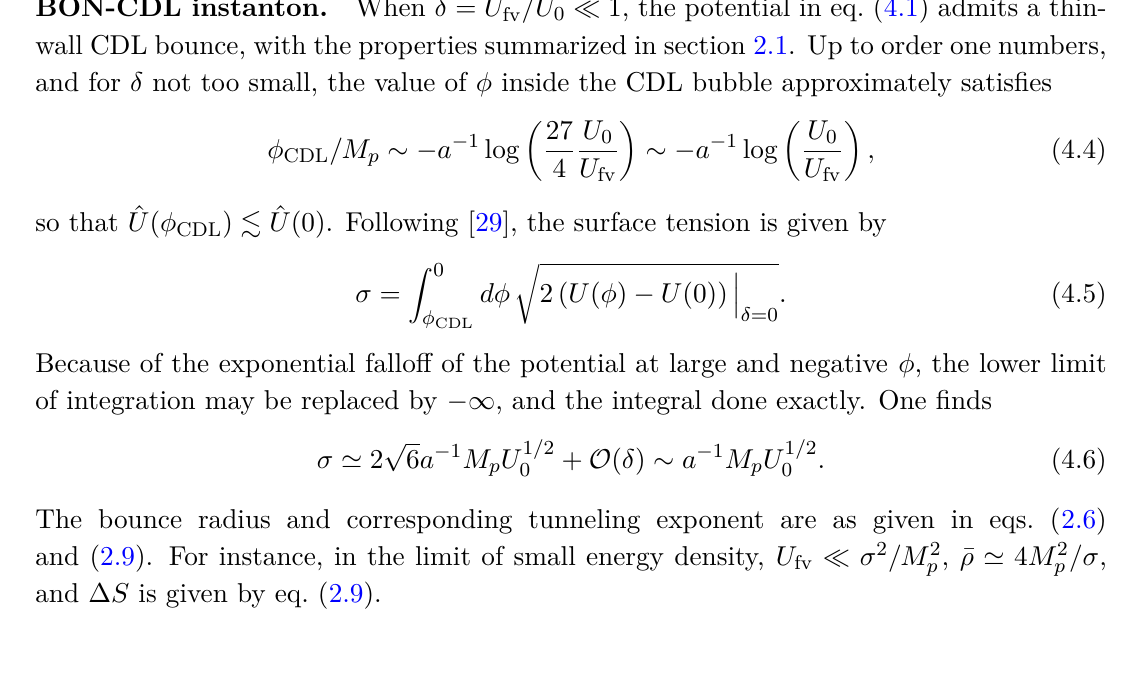
Figure 21: Potential U (